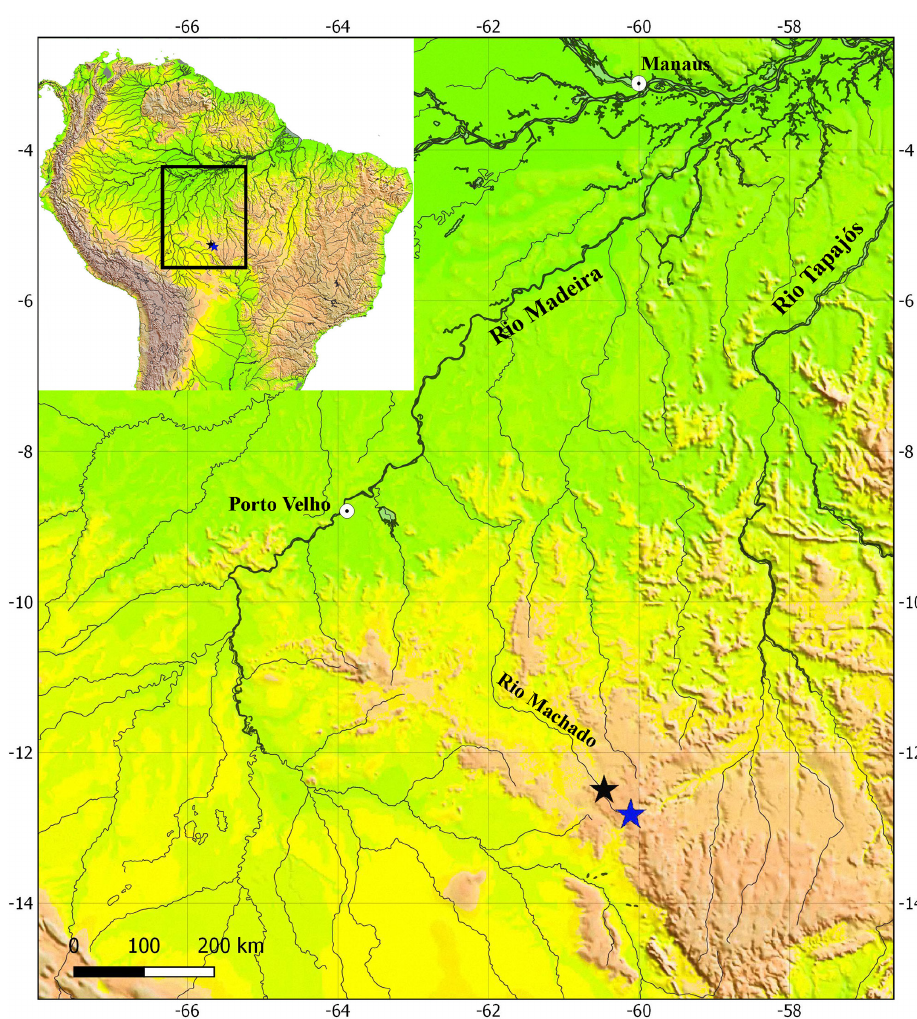
FIGURE 6 | Distribution of Moenkhausia cambacica in the upper rio Machado, rio Madeira basin, Brazil. Black star (type-locality), blue star (other